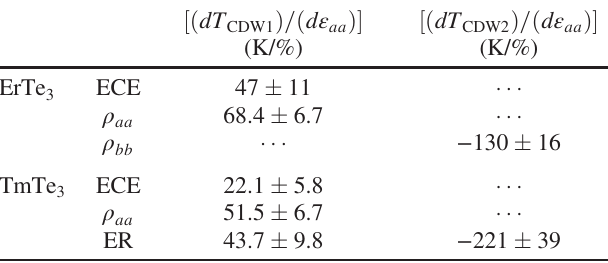
EVIDENCE FOR REALIGNMENT OF THE CHARGE DENSITY TABLE I. Rate of change of the critical temperatures T CDW 1 and T with strain in the strain-induced q a state. In all of CDW 2 these experiments, uniaxial stress is applied along the a axis. Not all techniques are sensitive to T . The strain range of the ρ bb CDW 2 measurements was insufficient to observe consistent linear behavior in T . Sources of sample-to-sample variation are CDW 1 described in the text.